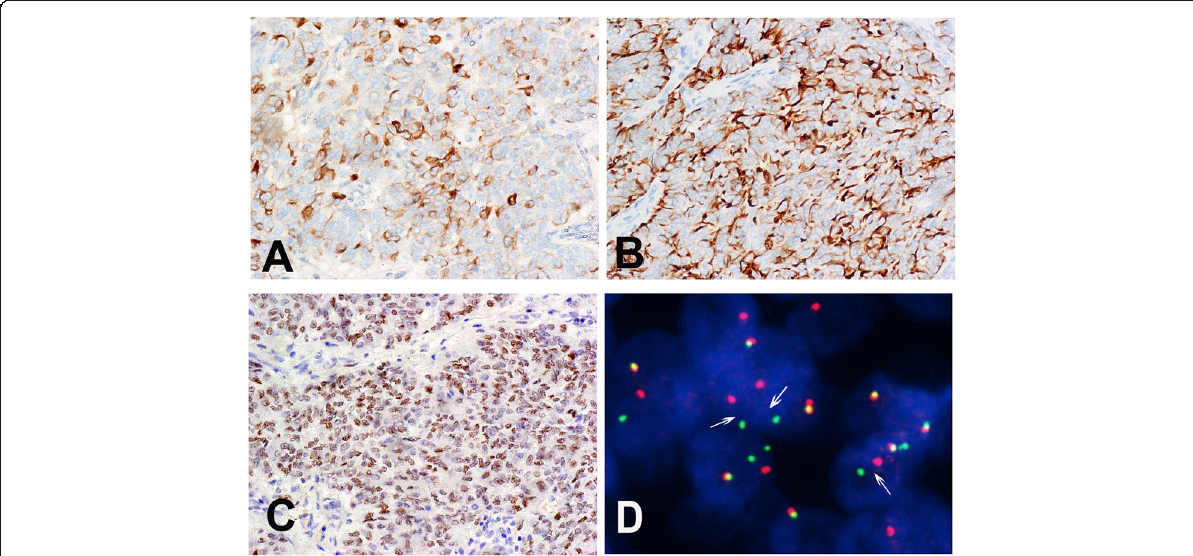
Fig. 2 Immunohistological and molecular features of the UTROSCT. a AE1/AE3 was positive in the UTROSCT (× 400). b Neoplastic cells expressed desmin in the cytoplasm (× 400). c Neoplastic cells expressed WT1 in the nuclei (× 200). d FISH studies. NCOA2 showing split-apart red and green signals in the tumor cells